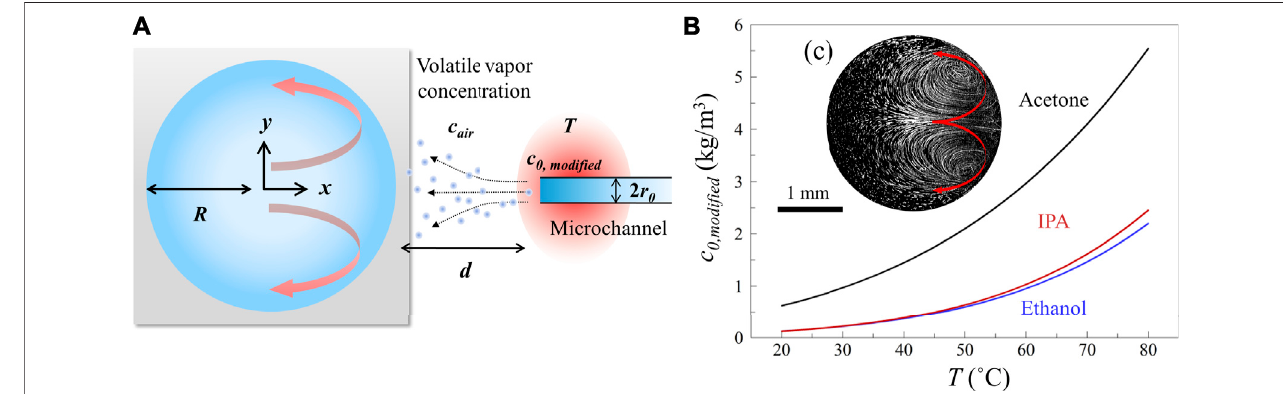
FIGURE2|(A) Aschematicofenhancedvapor-drivensolutalMarangonieffect. (B) Vaporconcentration( c 0,modi fi ed ) -temperature (T) pro fi leofseveralvolatileliquids (acetone, isopropyl alcohol (IPA), ethanol). (C) Stacked particle image of vapor-driven solutal Marangoni fl ow by acetone at 50 ° C.